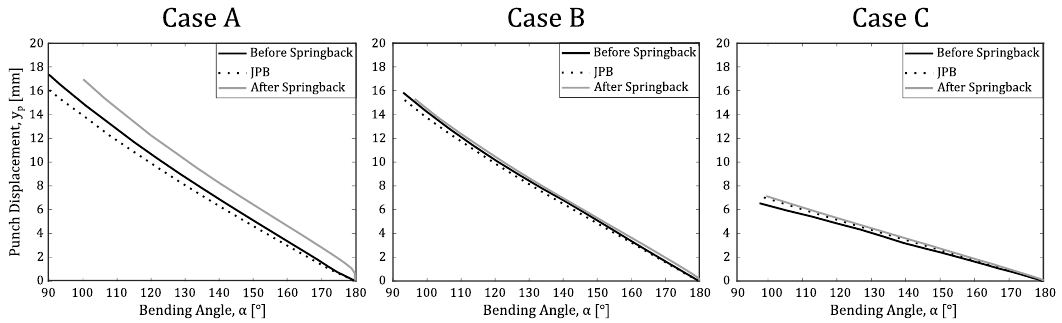
Figure 5. Punch displacement ( y p ) graphs as a function of required bending angle ( α ) for cases A–C. The springback angle, ∆ α SB is represented in Figure 6 for different V / t ratios and assuming different desired bending angles, α . The values for the cases A and B are also represented. This representation reinforces that higher V / t ratios promotes the material elastic recovery, which is translated in a higher difference between the angle before and after tooling removal. Additionally, it is visible that springback angle increases during the bending operation. Therefore, for a final bending angle of 90 ◦ , the springback angle for cases A and B are 14º and 3º respectively.